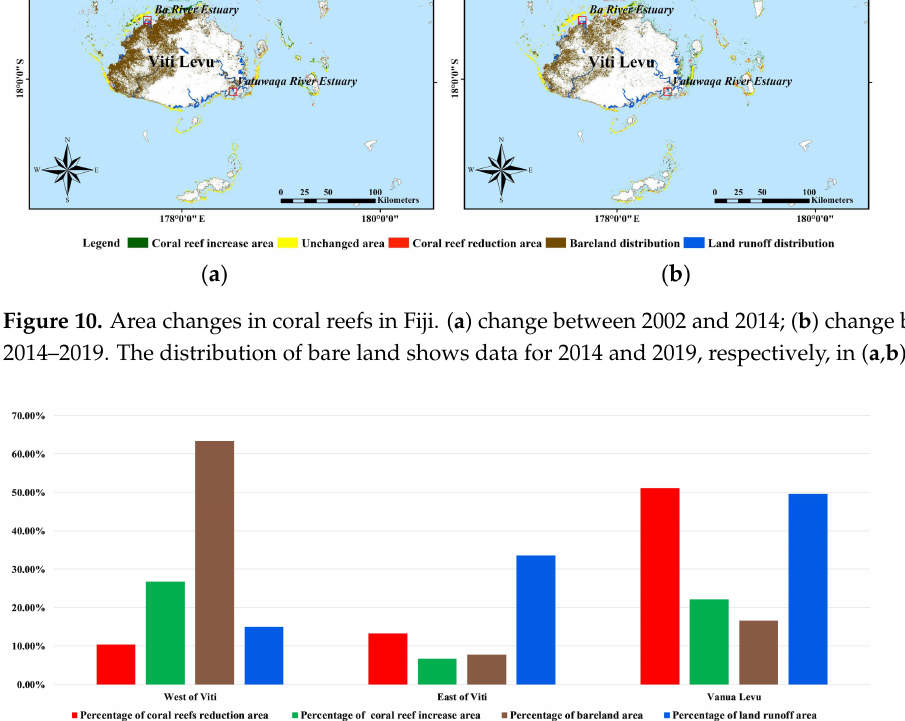
Figure 11. Area percentage histogram of bare land, land runoff area, and coral reef change area in surrounding waters of Viti Levu and Vanua Levu. In each area, both decreases and increases of coral reefs occurred in specific land-use type